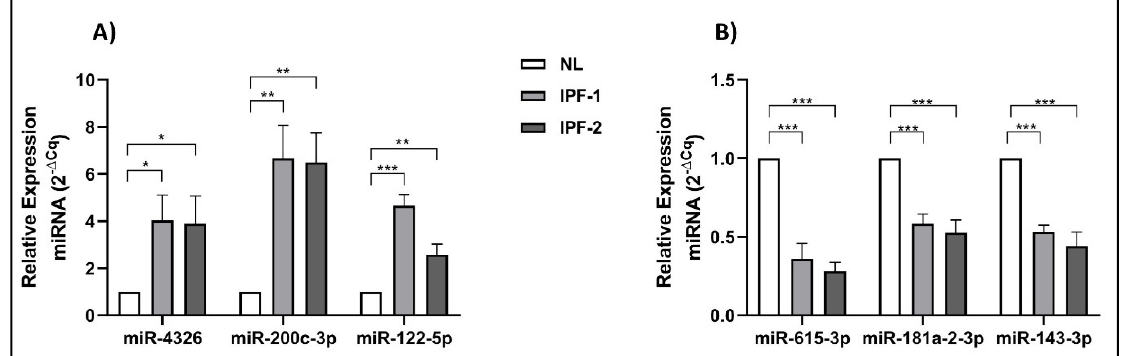
Figure 7. Hub DE-miRNAs were validated by performing quantitative RT-PCR. The relative expres- sion levels of ( A ) 3 up regulated miRNAs (miR-4326, miR-200c-3p, and miR-122-5p) and ( B ) 3 down regulated miRNAs (miR-615-3p, miR-181a-2-3p, and miR-143-3p) in EVs from fibroblast with IPF and healthy, were determinated by qRT-PCR. Compared with the expression basal from healthy miRNAs, 6 miRNAs were significantly higher and lower, respectly. (*, **, *** p <